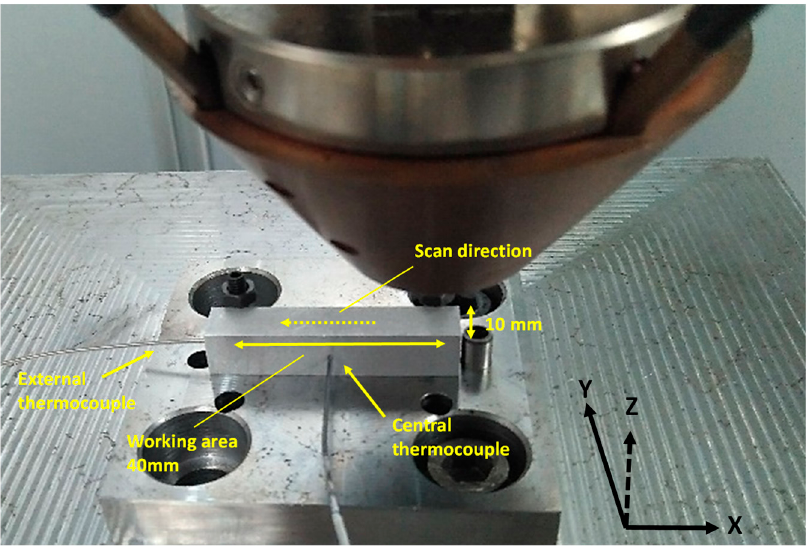
Figure 2. Experimental set-up of the positioning of the samples with the thermocouples on the LMD base.